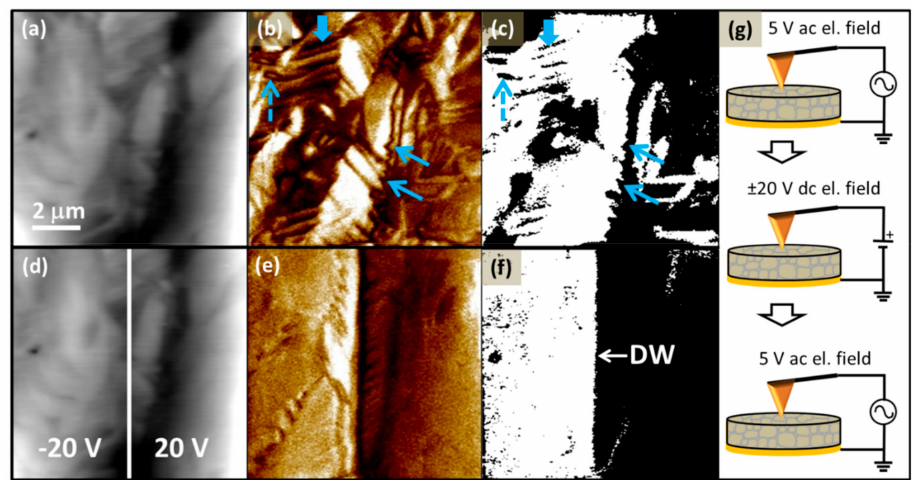
Figure 6. Topography ( a , d ), PFM out-of-plane amplitude ( b , e ), and phase ( c , f ) images (drive AC signal: 5 V, 350 kHz) before (up) and after (down) in situ poling with ± 20 V at ambient temperature. ( g ) Schematic presentation of in situ poling experiment. Areas of di ff erent poling regimes are shown in ( d ). Examples of wedge, lamellar-like, and irregularly shaped domains are marked by solid, thick solid, and dashed arrows, respectively. Created DW is marked by an arrow in ( f